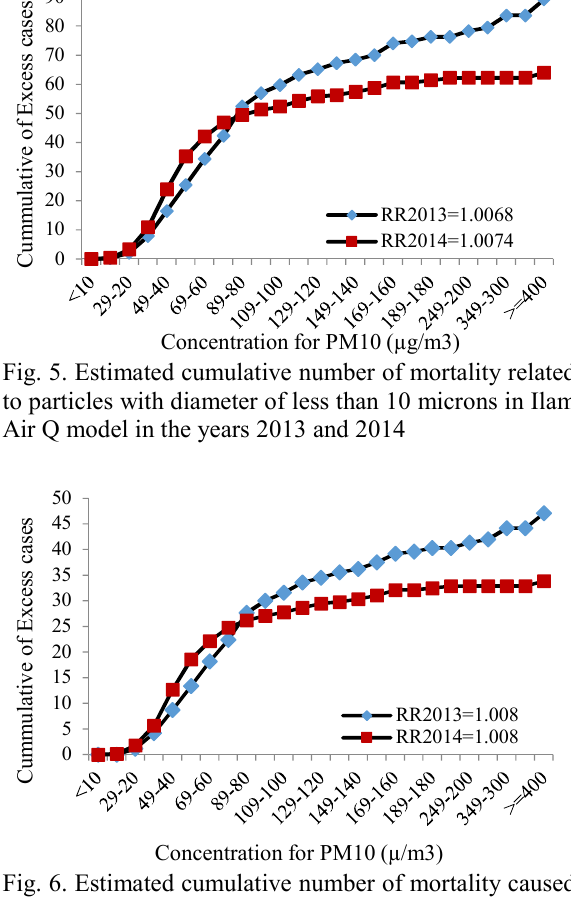
Fig. 6. Estimated cumulative number of mortality caused by cardiovascular diseases related to particles with a diameter less than 10 microns in Ilam using Air Q model in 2013 and 2014